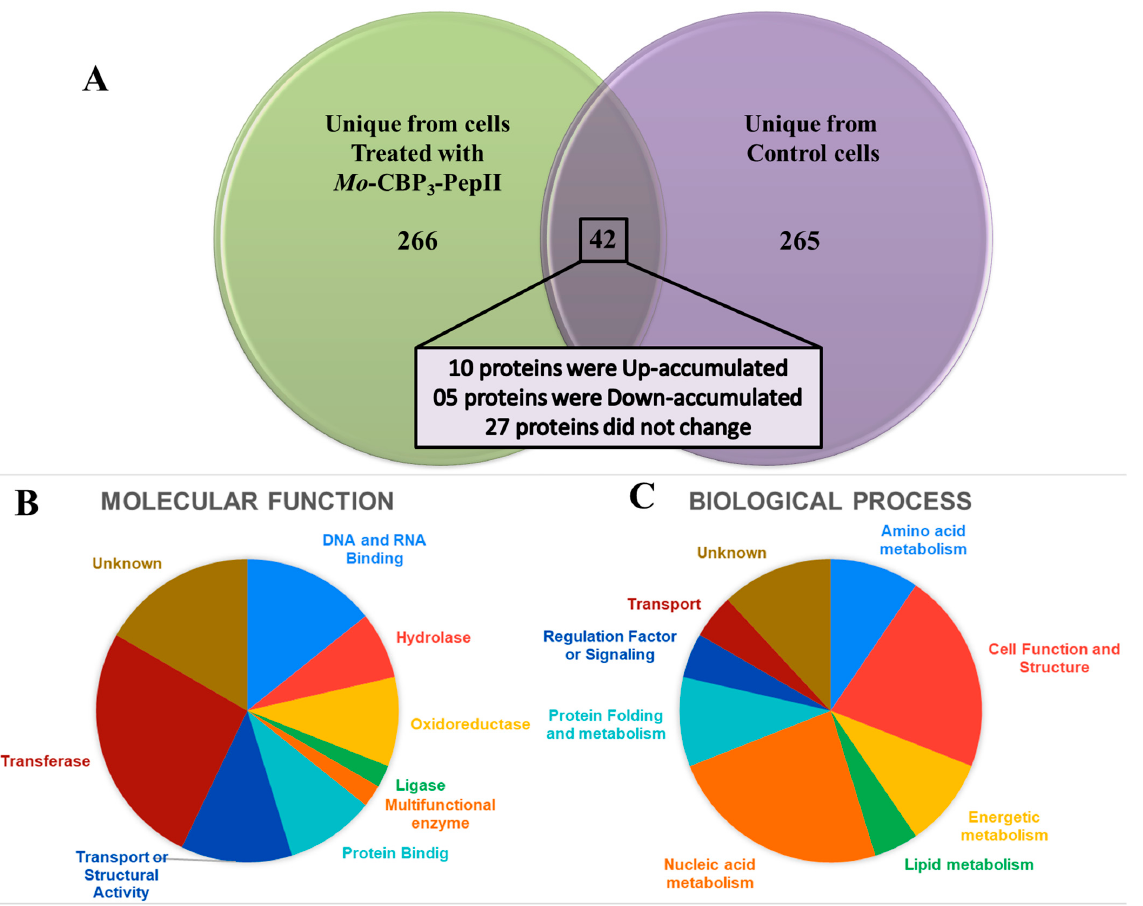
Figure 6. Differentially accumulated proteins in C. neoformans cells treated with Mo-CBP3-PepII. In ( A ), the Venn diagram highlights the differential distribution of proteins in treated and non-treated cells unique from each group and the overlapping protein found in both groups with differential accumulation. ( B ) Proteins are classified according to molecular function. ( C ) Proteins are classified according to biological processes. Table 1. Overlapping proteins identified in control and treated cells of C. neoformans by LC-ESI- MS/MS analysis.